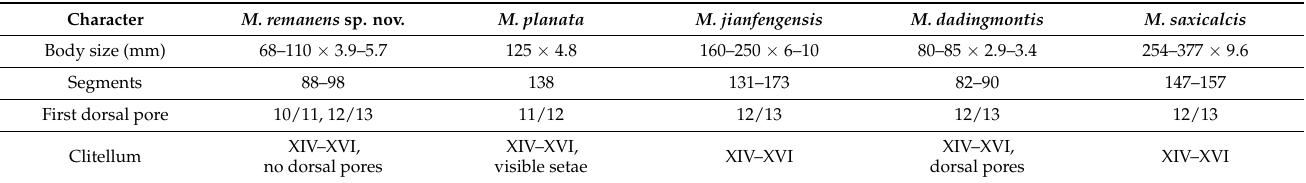
Table 4. Comparison of characteristics of M. remanens sp. nov., M. planata , M. jianfengensis , M. dadaingmontis , and M. saxicalcis